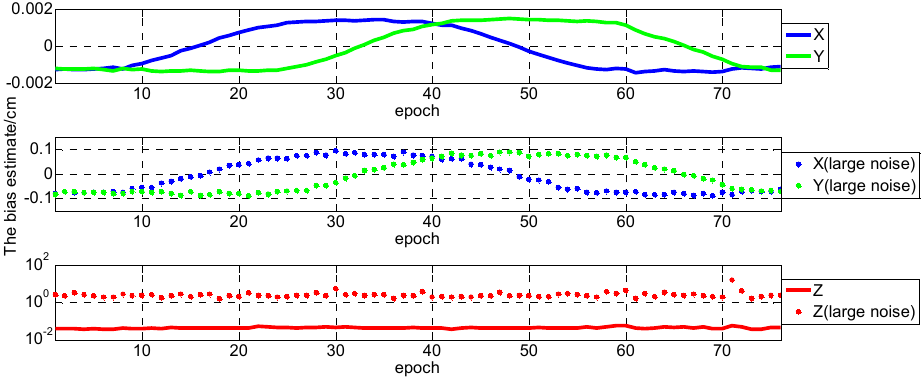
Figure 16. The bias estimate of two set of tests.